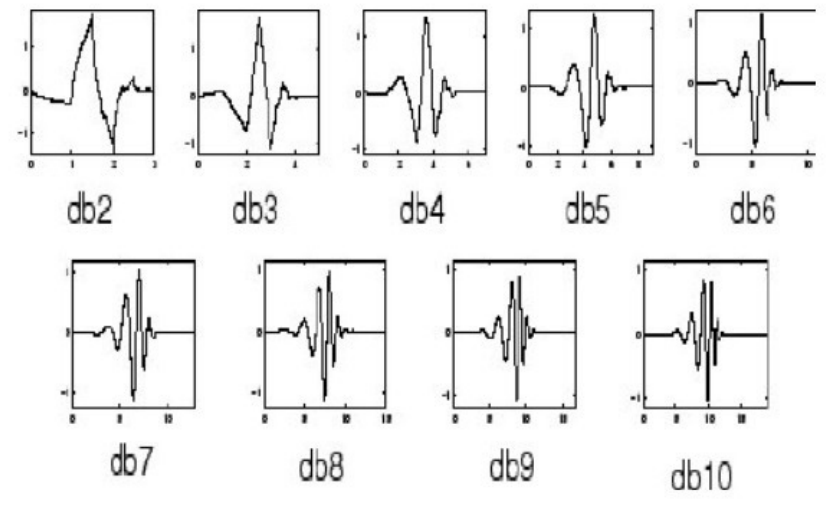
Figure 6. Daubechies wavelet